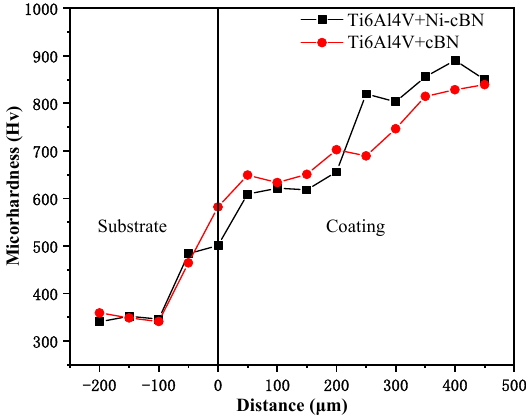
/ Ti6Al4V and cBN / Ti6Al4V composite Figure 8. The microhardness of the NicBN/Ti6Al4V and cBN/Ti6Al4V composite coatings. Figure 8. The microhardness of the NicBN